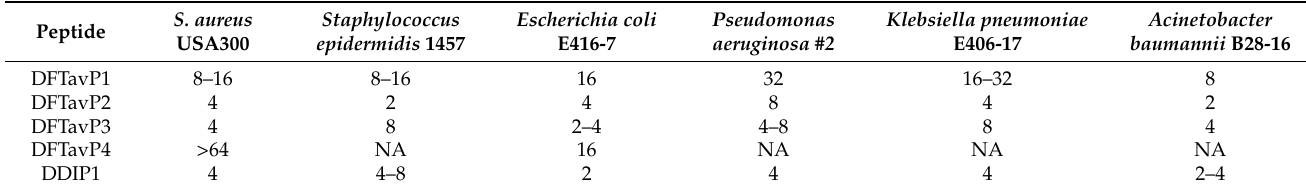
Table 2. Minimum inhibitory concentration ( µ M) of database-designed antiviral